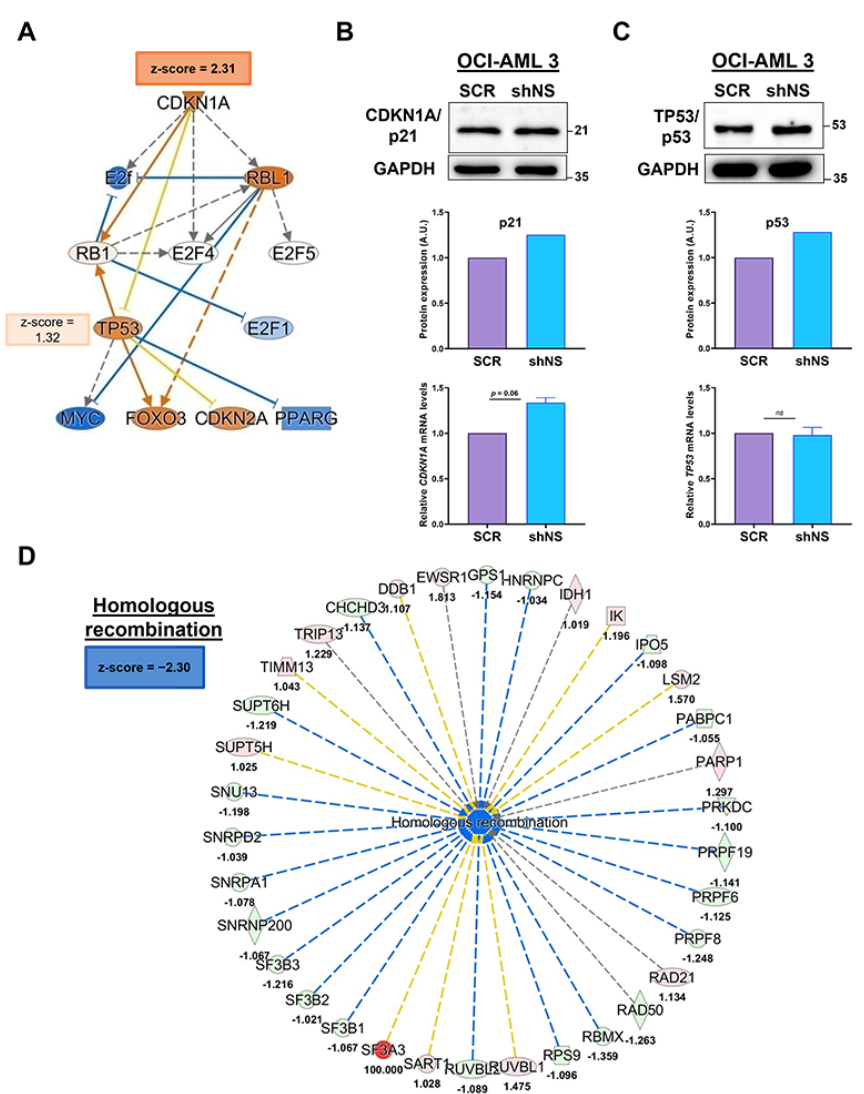
Figure 2. Functional Proteomics Analysis revealed the activation of CDKN1A/p21 as an upstream regulator in NS-silenced OCI-AML 3 cells corroborated with a strong inhibition of homologous recombination function. ( A ) Mechanistic network of the putative upstream regulator CDKN1A/p21 protein and its significant levels of activation predicted by IPA (z-score = 2.31) for the comparison of OCI-AML 3 shNS/OCI-AML 3 SCR. Within the network, some of the protein actors were directly or indirectly regulated by CDKN1A/p21, such as the TP53/p53 protein (z-score = 1.32, not significant ), colored according to IPA color code (see Supplementary Figure S4), based on their predicted levels of activation/inhibition. WB images and their corresponding quantifications of protein expression levels of ( B ) CDKN1A/p21 and ( C ) TP53/p53 in NS-silenced (shNS) or not (SCR) OCI-AML 3 cells. For each lane, 25 µg of total lysates were loaded. GAPDH is reported as loading control. For each protein considered, mRNA expression levels are expressed as ratios over OCI-AML 3 SCR cells and normalized for B2M. ( D ) Downstream network analysis shows a strong inhibition of “homologous recombination” in OCI-AML 3 shNS compared to its SCR control (z-score = − 2.30). The modulation of CDKN1A/p21 upstream in the comparison of OCI-AML 3 shNS/OCI- AML 3 SCR cells is likely linked to cell cycle control and DNA damage. Indeed, the significant up-regulation of CDKN1A/p21 in OCI-AML 3 shNS was corroborated by the down-regulation of the “ homologous recombination ” biological function (z-score = − 2.30; Figure 2D and Table 1) in the same cell line. This suggests that NS silencing in